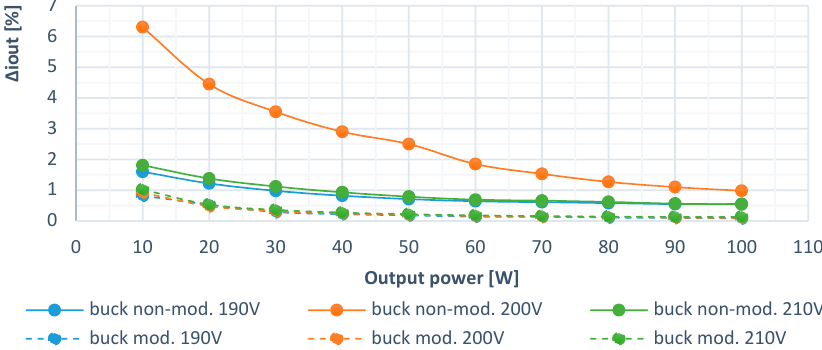
Figure 17. The dependency of output current ripple on output power and input voltage for proposed bi-BB converters for buck mode.